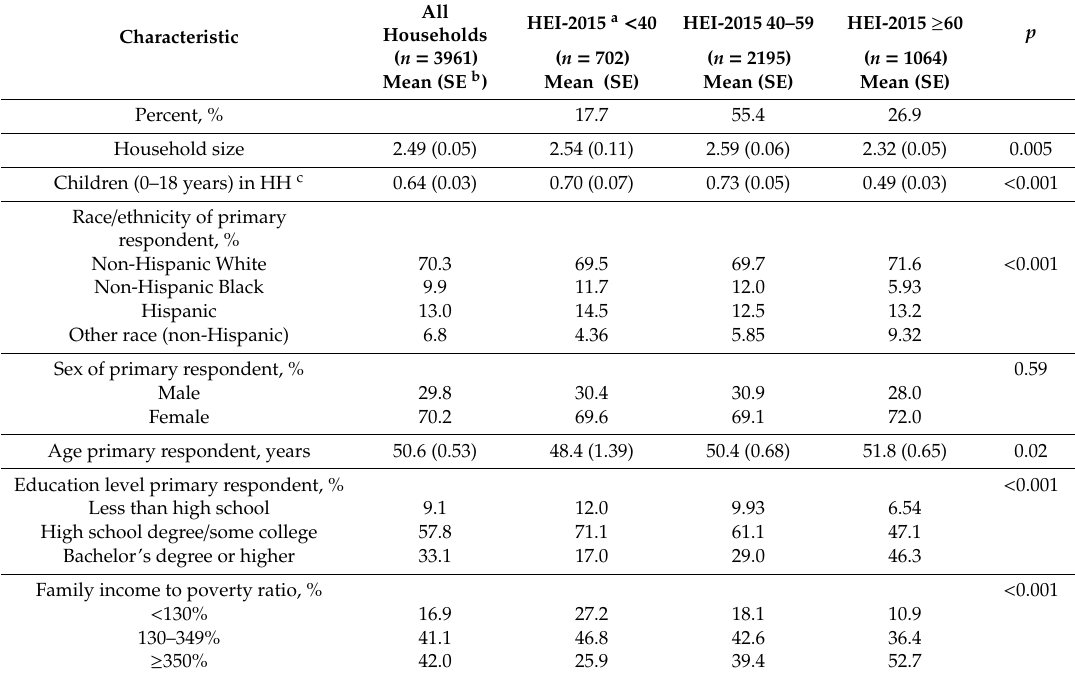
Table 1. Demographic, socioeconomic, and clinical characteristics of households participating in the National Household Food Acquisition and Purchase Survey 2012–2013 ( n = 3961), according to Healthy Eating Index 2015 total score group ( < 40, 40–59, and ≥ 60) for grocery purchases for food at